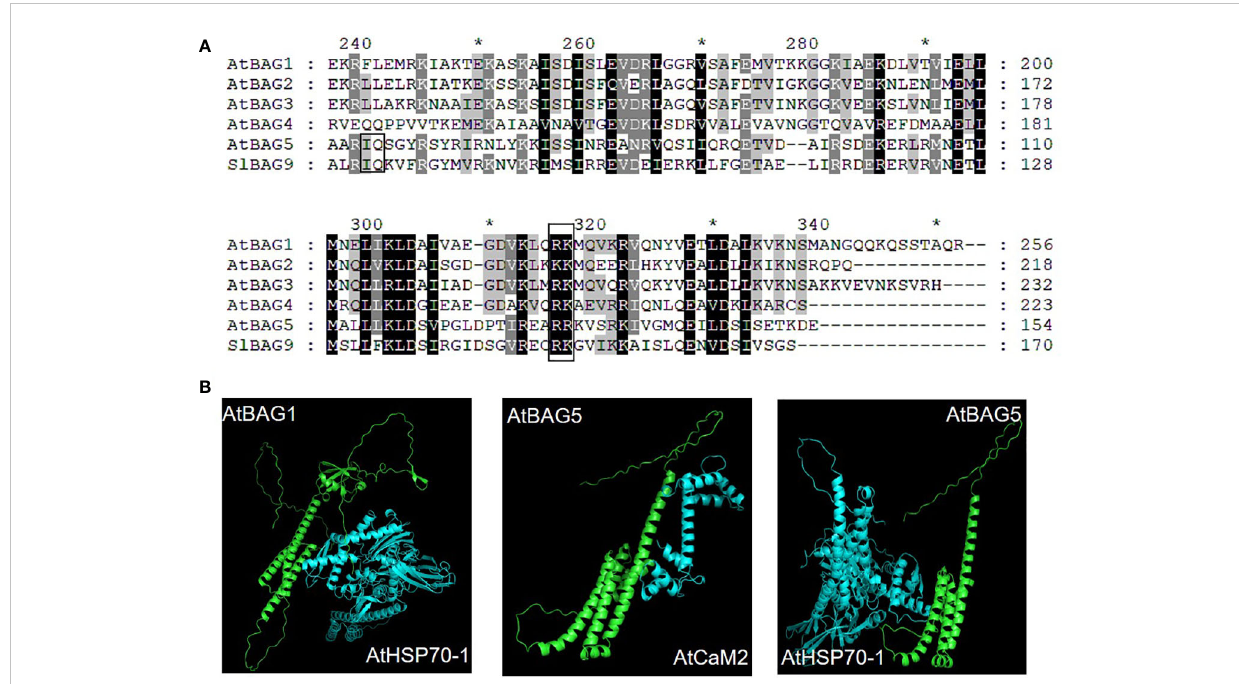
FIGURE 2 Recognition of AtBAG by Hsc70 and CaM. (A) Sequence alignment of AtBAG1-AtBAG5 and SlBAG9. Conserved residues are colored. Key residues responsible for the association of the BAG domain with Hsc70 and CaM are framed. (B) The models of the simultaneous interaction of AtBAG1 with AtHSP70 and AtBAG5 with AtCaM2 and the AtHSP70. Spatial structures of the AtBAG1, AtBAG5, AtHSP70, and, AtCaM2 were predicted based on target-template alignment on SWISS MODEL server (https://swissmodel.expasy.org/). Protein – protein docking models were generated using HADDOCK (https://wenmr.science.uu.nl/haddock2.4). * means the starting point of every 10 amino acid